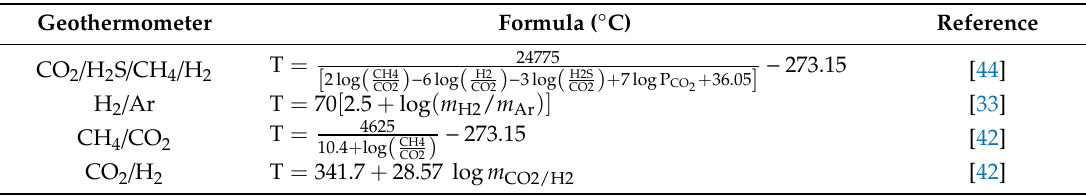
Table 2. Temperature equations ( ◦ C) for gas geothermometers.